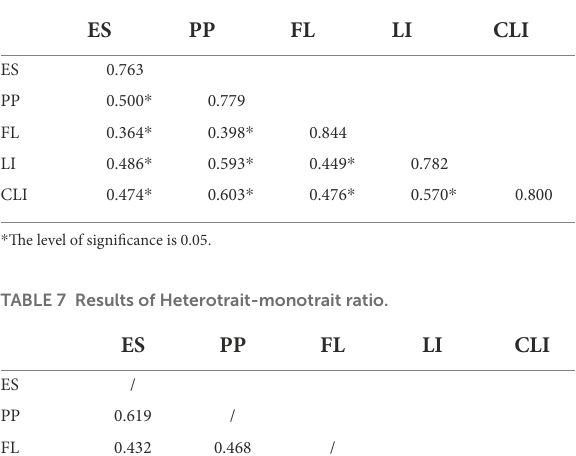
TABLE 8 Structural equation model